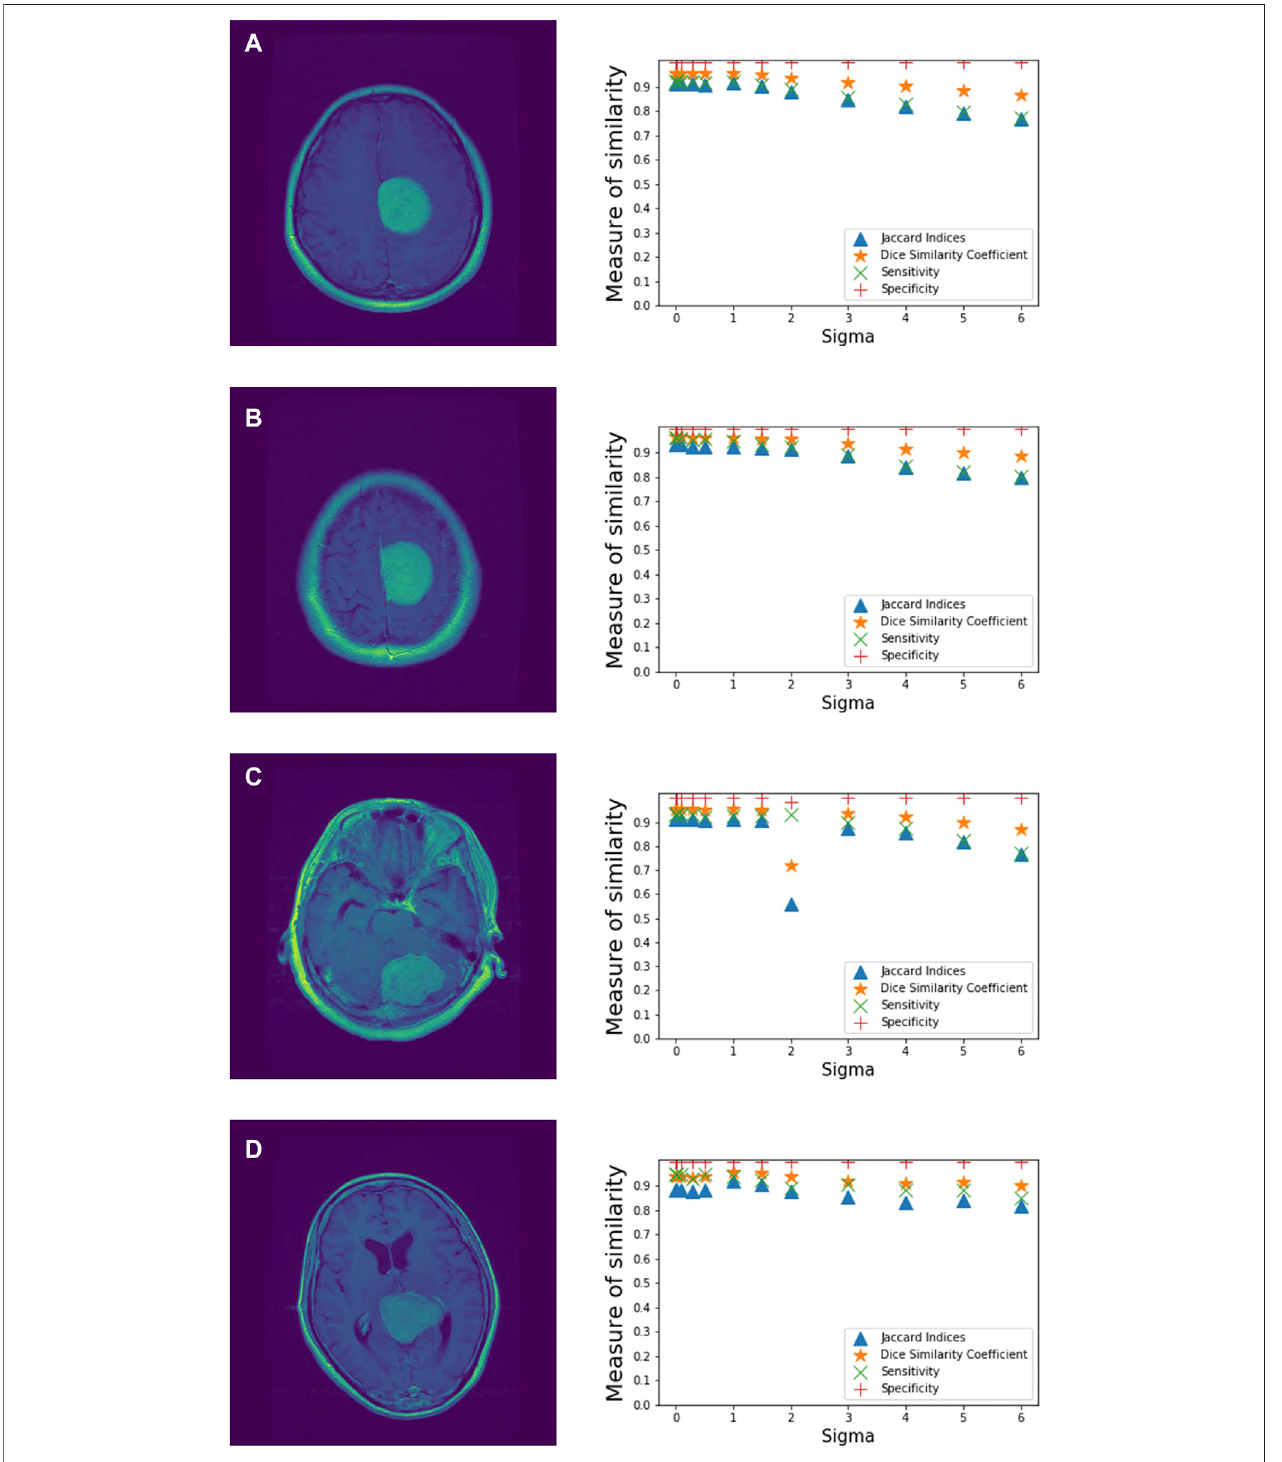
FIGURE8| In fl uenceofsigmaontheperformanceoftheminimumspanningtree-basedmethod. (A – D) Imagesandthecorresponding graphsshowingmeasures of similarity (vertical axis) of the segmented images using the minimum spanning tree method in relation to the tuned sigma (horizontal axis). The sigma values tested include: 0, 0.01, 0.1, 0.3, 0.5, 1.0, 1.5, 2.0, 3.0, 4.0, 5.0, and 6.0.